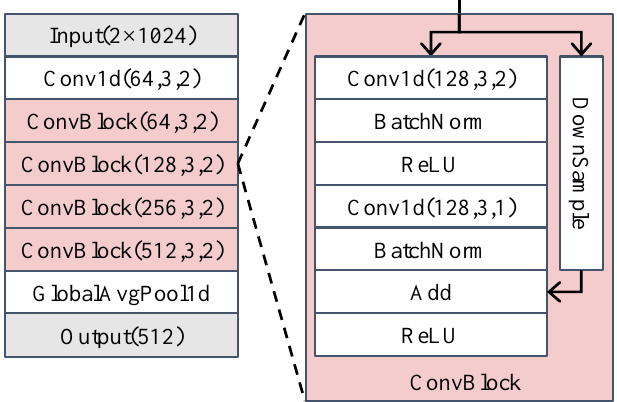
Figure 5. The architecture of the feature extractor for the simulated dataset.